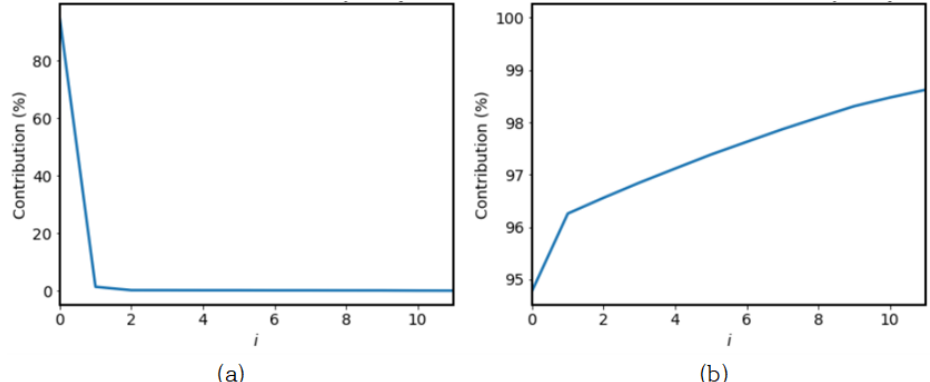
Figure 10. ( a ) Relative contribution graph and ( b ) Cumulative contribution of X i to trajectory matrix.